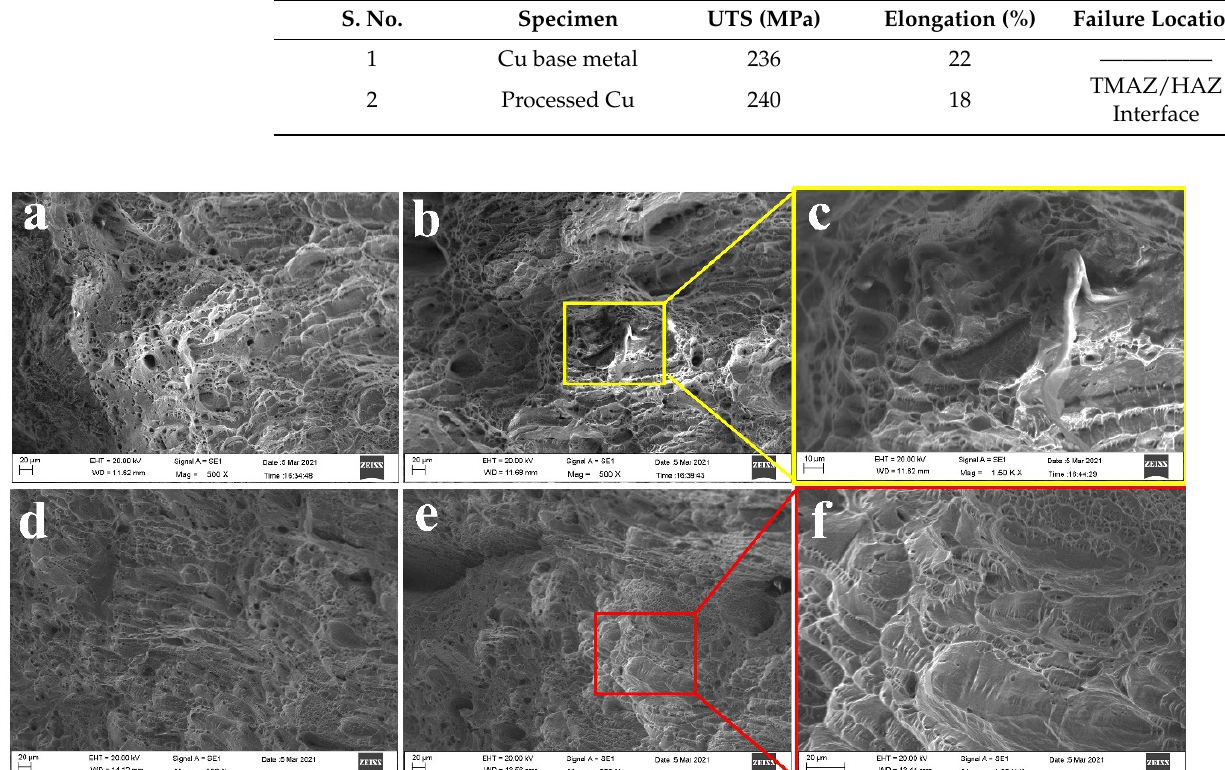
Table 3. Tensile properties of base metal and test sample cut from processed plate.